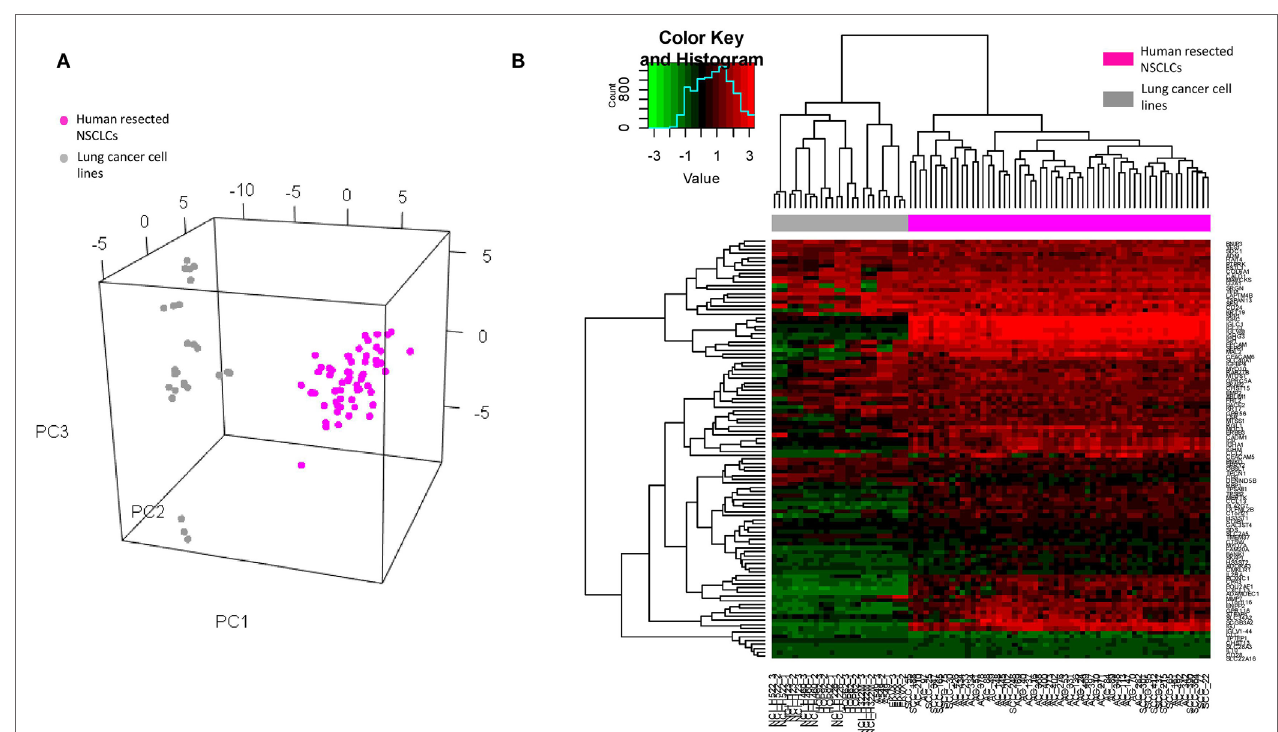
FigUre 3 | (a) Visualization of principle component analysis using the standardized expression matrix of differentially expressed genes of bronchoalveolar lavage cells extracted from the datasets GSE10245 (magenta, n = 58) and GSE32474 (gray, n = 26), which corresponded to the human resected non-small cell lung cancer (NSCLCs) and the nine lung cancer cell lines of the NCI-60 human tumor cell lines panel, respectively. (B) Unbiased clustering of the same expression matrix clearly differentiating resected tumors from cell lines.